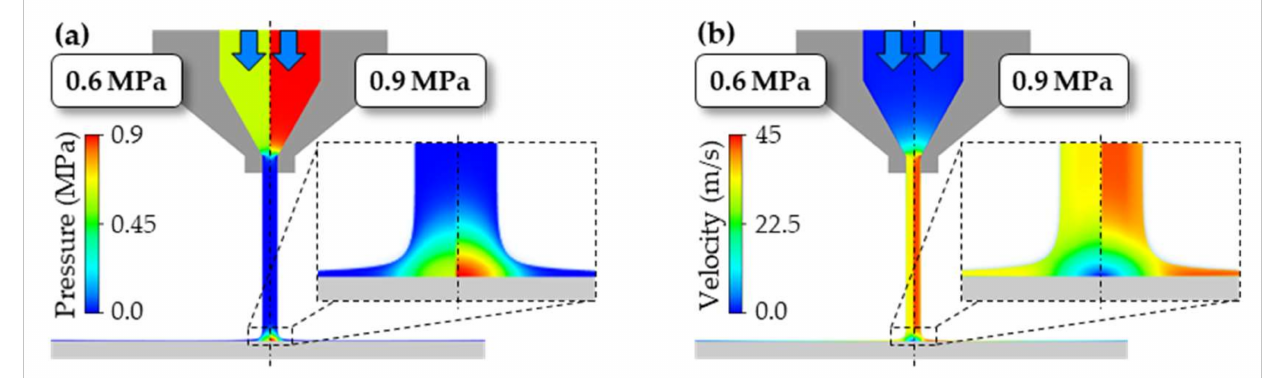
Figure 13. Numerical results of pressure ( a ) and velocity ( b ) fields of liquid jet impinging the workpiece surface. The liquid is water with an inlet pressure of 0.6 and 0.9